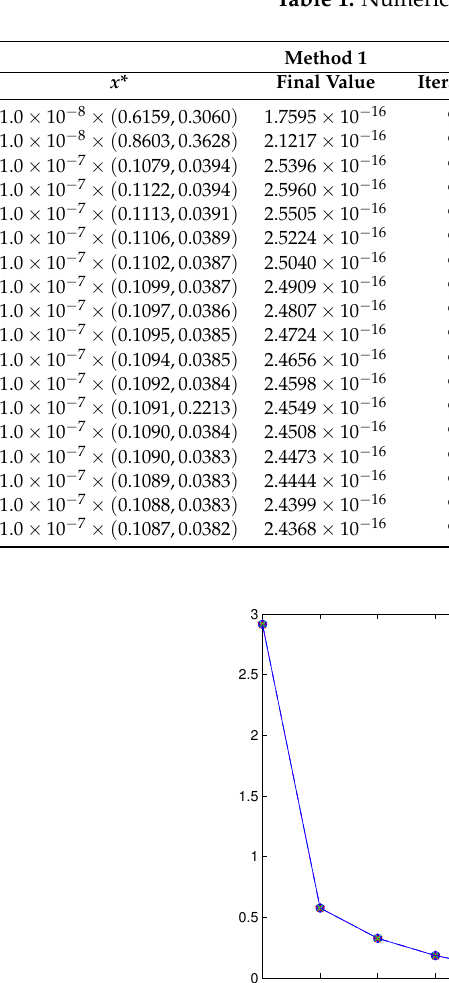
Table 1. Numerical results for Example 1.